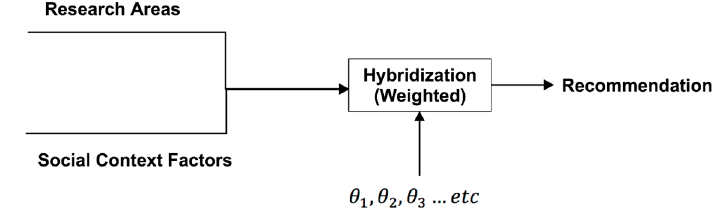
Figure 3. Hybrid recommendation approach.